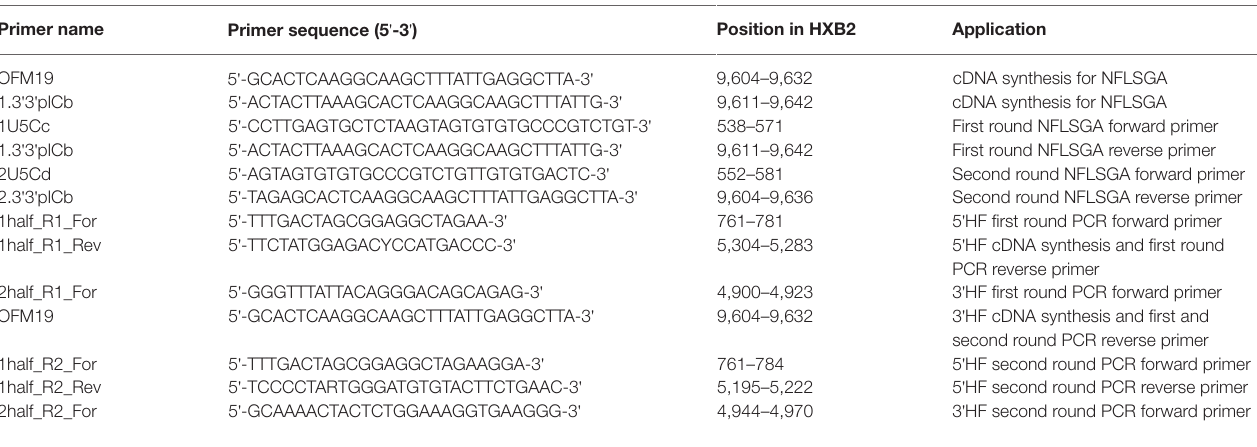
TABLE 1 | cDNA and PCR